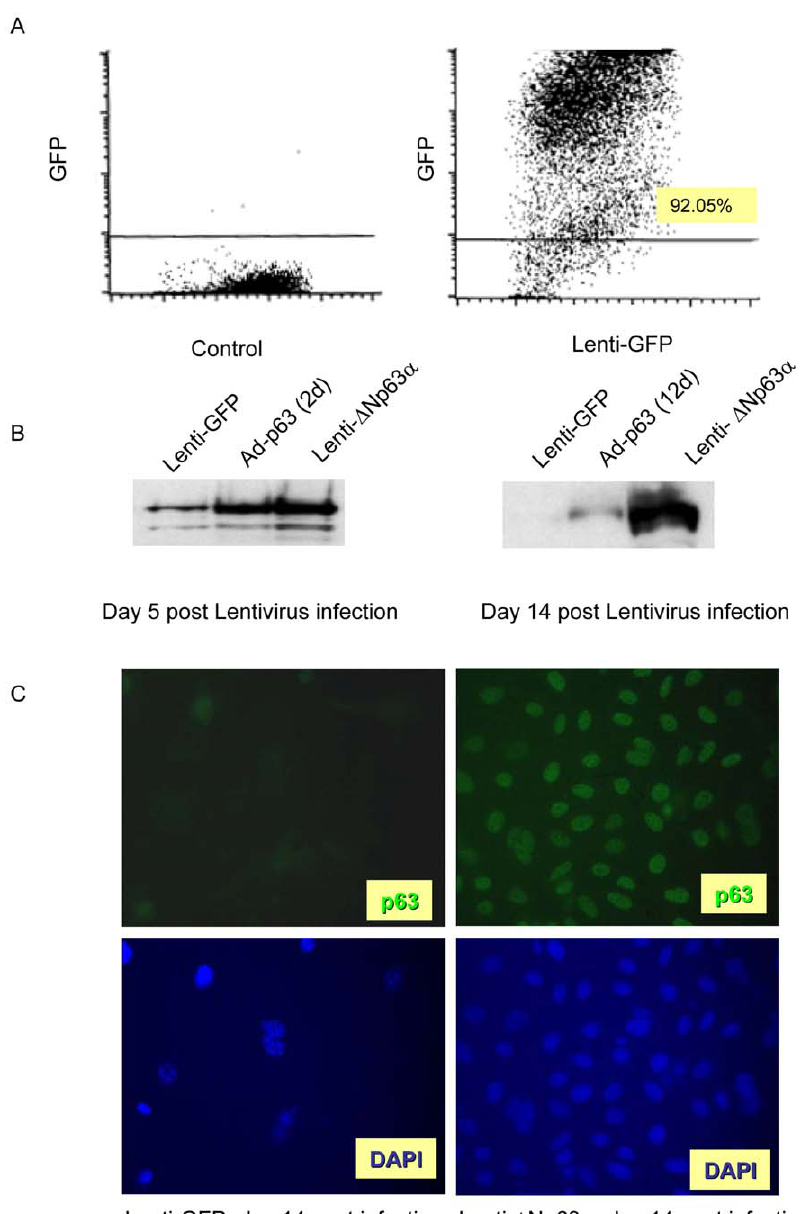
Figure 1. Lentivirus infection drives long term and stable gene expression in primary keratinocytes. A, Primary mouse keratinocytes were infected with lentivirus encoding GFP, and infection efficiency was assessed by FACS analysis at day 5 post-infection. Y-axis indicates the intensity of GFP, X-axis represents forward angle light scatter. B, Primary keratinocytes were infected with lentivirus encoding GFP or D Np63 a and whole cell protein was collected at day 5 and 14 and analyzed for p63 expression by western blot. C, Primary keratinocyte cultures expressing lenti- GFP or lenti- D Np63 a were fixed at 14 days post-lentiviral transduction and incubated with anti-p63 antibody, followed by a secondary antibody conjugated with Alexa-488. The cells were then stained with DAPI to visualize the cell